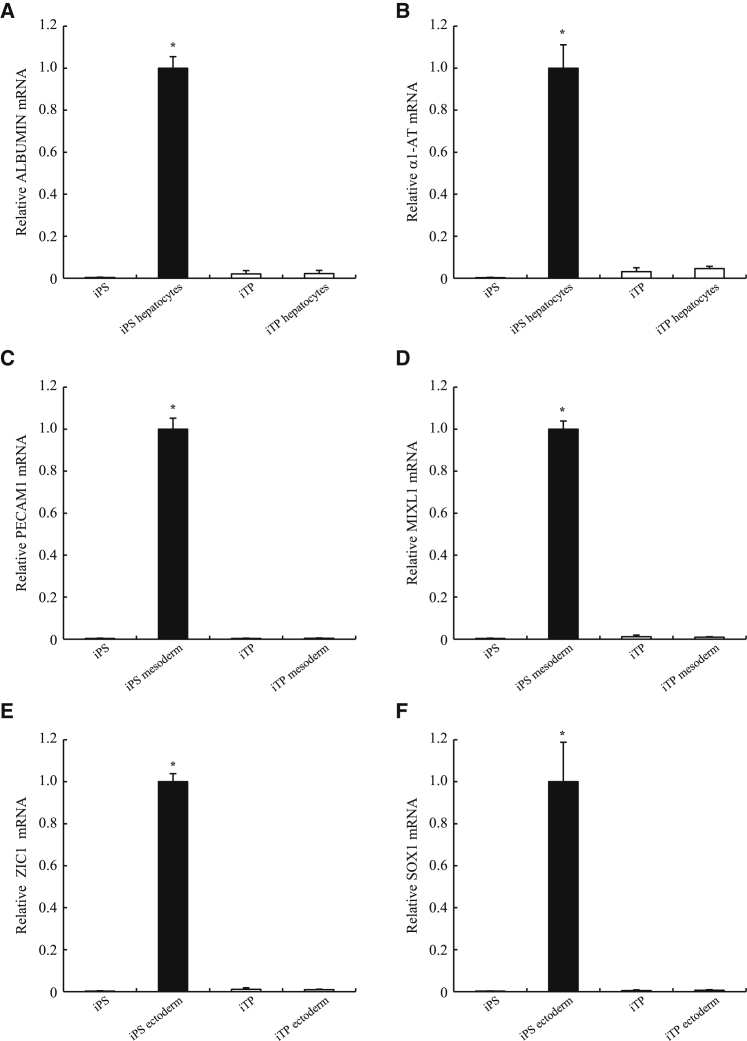
Restriction of the Developmental Potential of iTP Cells(A) qRT-PCR analysis of ALB expression in undifferentiated and differentiated iTP cells. (B) qRT-PCR analysis of α1-AT in undifferentiated and differentiated iTP cells. (C and D) qRT-PCR analysis of mesodermal genes PECAM1 (C) and MIXL1 (D) in undifferentiated and differentiated iTP cells. (E and F) qRT-PCR analysis of the expression of the neuroectodermal genes ZIC1 (E) and SOX1 (F) in undifferentiated and differentiated iTP cells. iPSCs and the differentiated cells derived from iPSCs were used as controls. *p < 0.05 compared with other cells. The data are expressed as the gene-to-GAPDH ratio, with that of the differentiated cells from iPSCs arbitrarily set to 1 (n = 4). Error bars represent the SE.